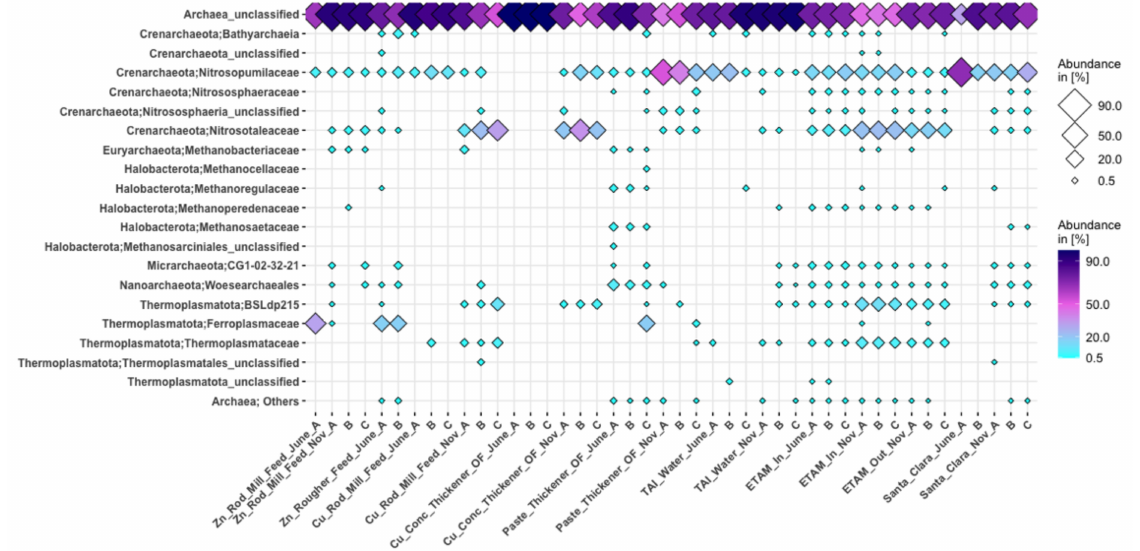
Figure 8. Archaeal classes containing at a minimum 1% relative abundance in at least one sample and other low abundance classes are combined into Archaea; Others. Sampling was performed in June and November 2018 originally with triplicate samples but only samples with over 20 reads are shown. The archaeal genera are presented on the left of the graph and the relative abundances of the different genera in each sample are represented by a gradient shading and size of the